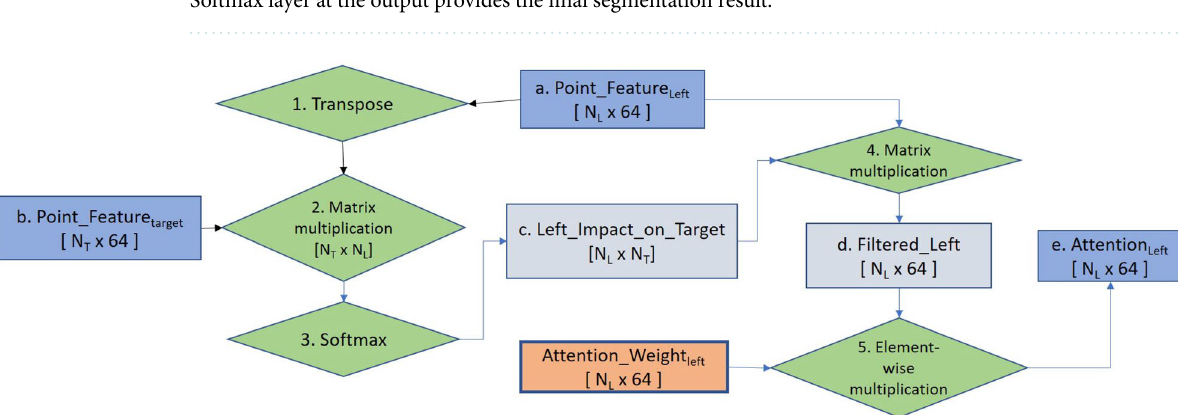
Figure 6. The network of IsoDetecting module. This network goes through three steps, finding the local features, global features, and point features respectively of the given target window. The number of layers and neurons in the Multiple Parceptron Layers (MLP) and Fully Connected Layers (FCL) is determined by experiments and mentioned in the figure. Point features of the target window are then diffused with features of surrounding regions based on their attention or influence over the target window (calculation of Attention _ left and others are shown in the next figure). Finally, the diffused features are passed through four MLP, and the Softmax layer at the output provides the final segmentation result.